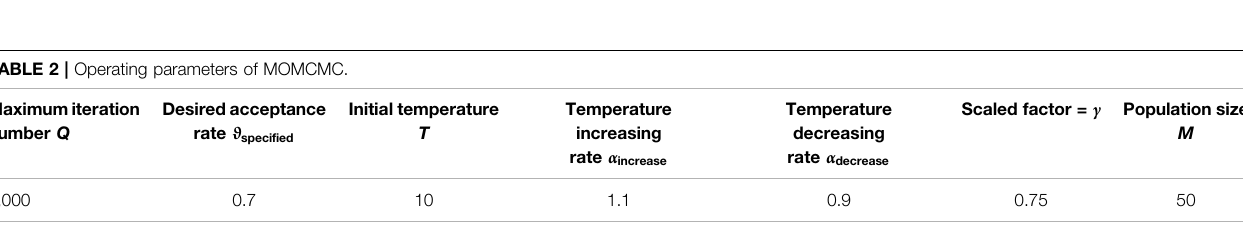
TABLE 2 | Operating parameters of